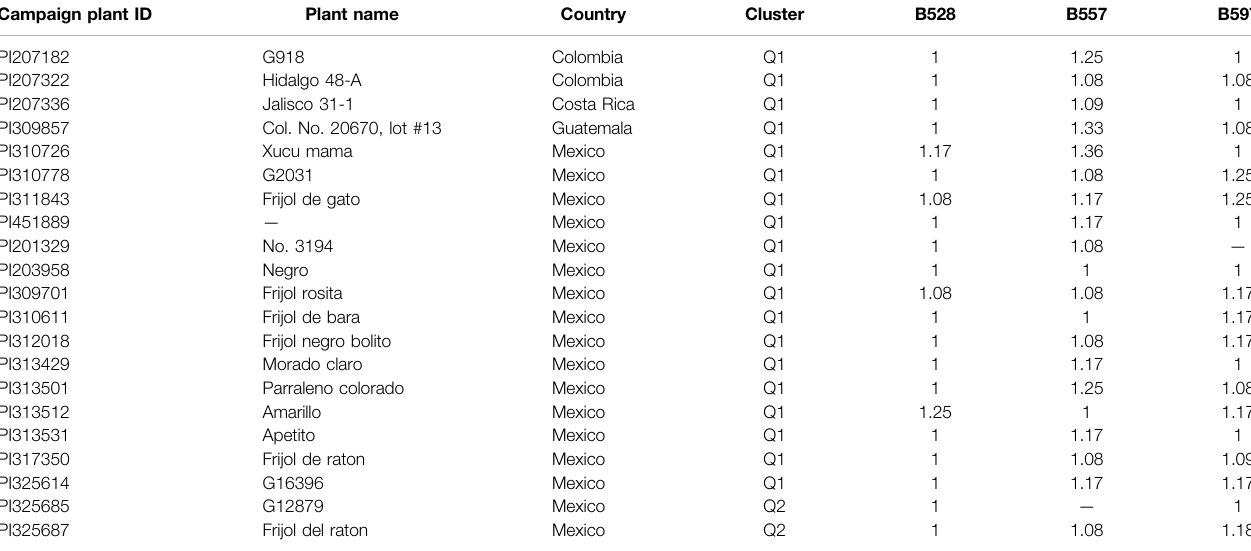
TABLE 1 | List of 21 common bean accessions with resistance to three bacterial wilt (BW) isolates, B528, B557, and B597. Campaign plant ID